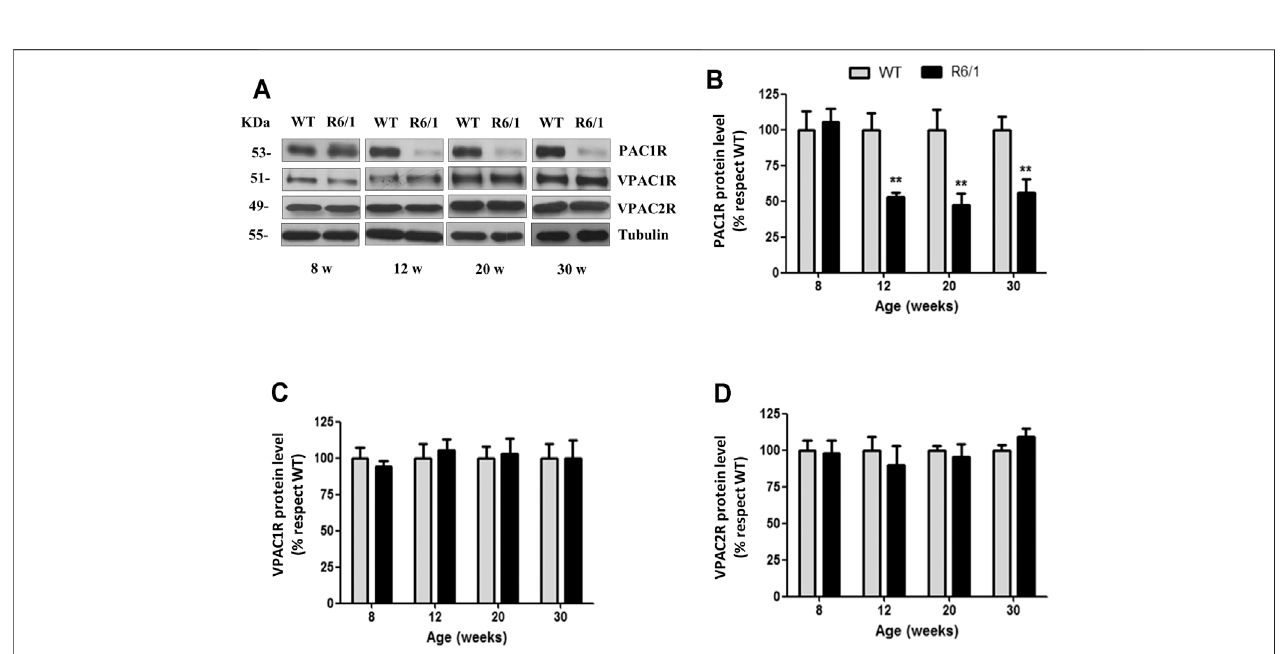
FIGURE 9 | PAC1R is reduced in the motor cortex of R6/1 mice from 12 weeks of age. Protein levels of PAC1R, VPAC1R, and VPAC2R were analyzed in striatal samples of WT and R6/1 mice at different ages by Western blot. (A) Representative immunoblots are shown. Quanti fi cation of (B) PAC1R, (C) VPAC1R, and (D) VPAC2R wasperformed.Results (mean ± SEM; n (cid:1) 7) were normalized tothe loadingcontroltubulinand are expressed asapercentage respect to WT mice.Statistical analysis was performed using unpaired Student ’ s t -test. ** p < 0.01 as compared to WT mice.